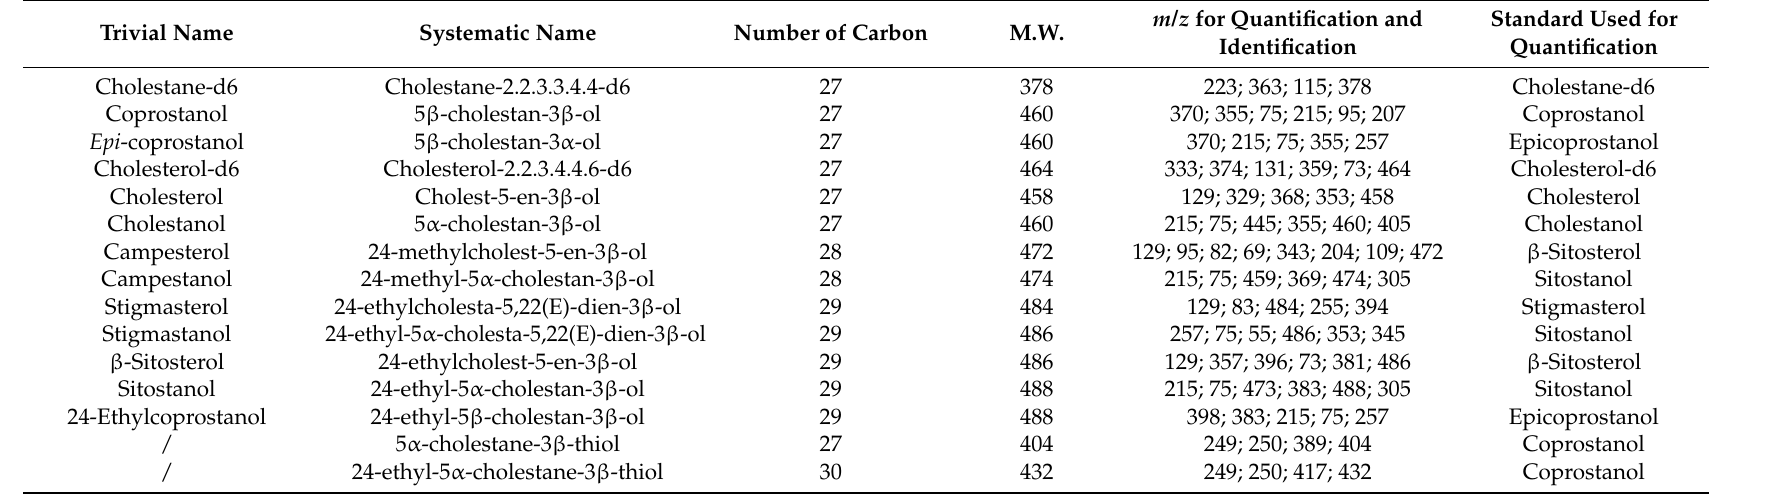
Table 1. Trivial and systematic names of the quantified sterols, their carbon number, molecular mass of their silylated counterparts (M.W.), the m / z and standard used for